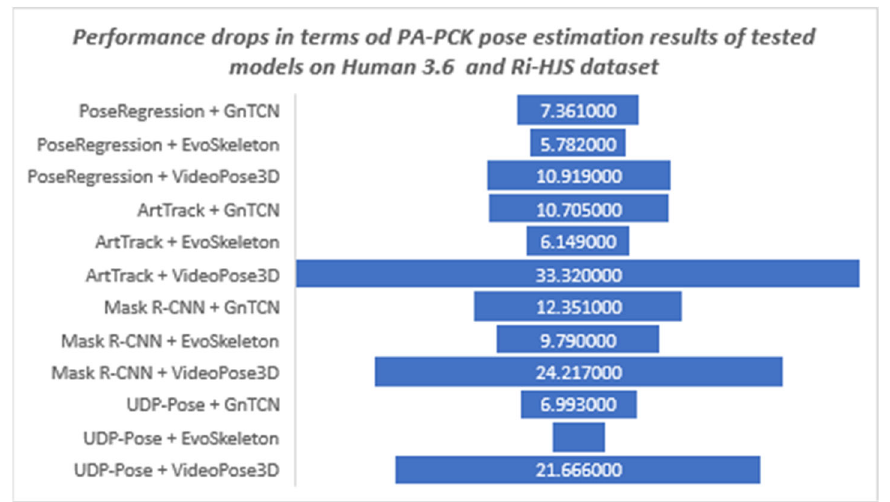
Figure 15. The robustness of the tested 3D models trained on the Human3.6M dataset shown as a difference of obtained results and performance drops between PA ‐ PCK pose estimation results on Human 3.6M and custom RI ‐ HJS datasets. Pose sequence estimation on RI ‐ HJS datasets after smooting and retargeting in terms of PA ‐ PCK results